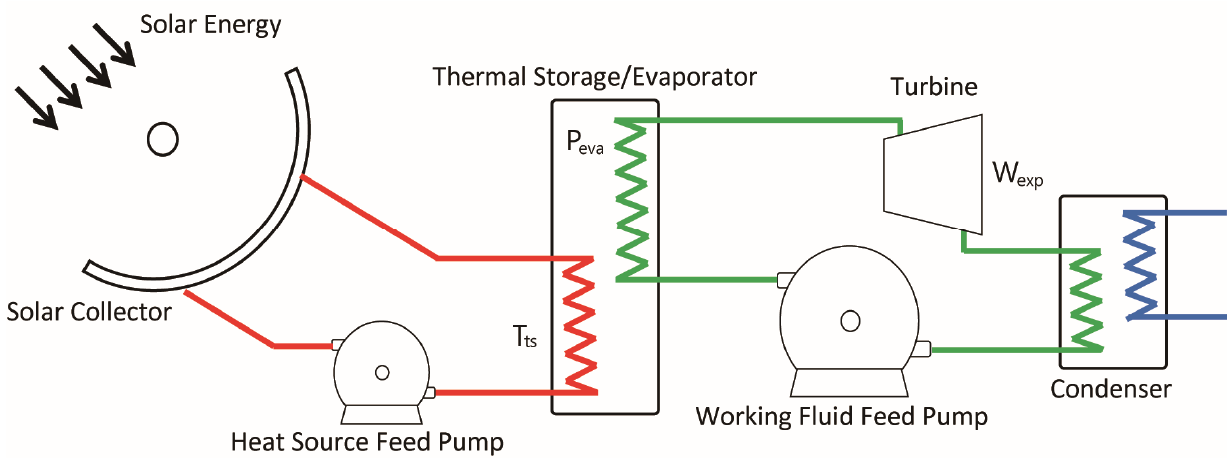
Figure 4. Schematic diagram of the solar organic Rankine cycle (SORC)